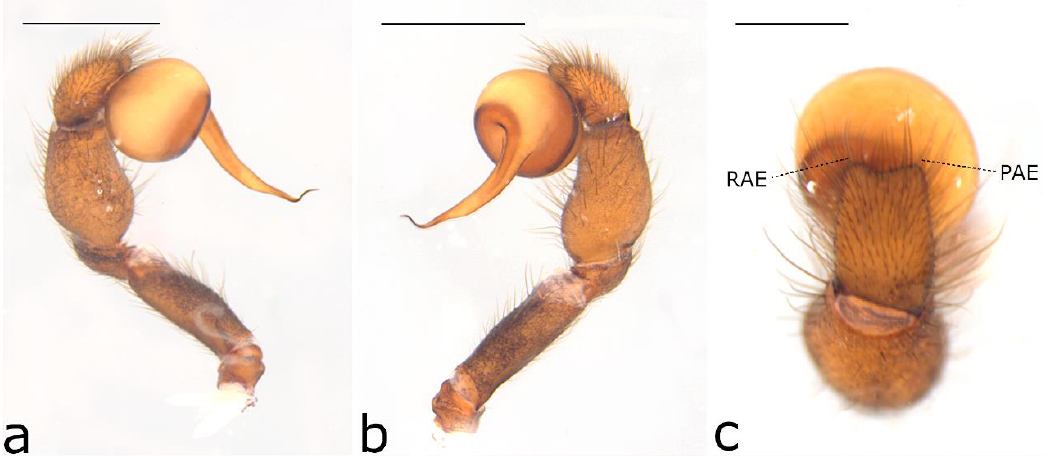
Figure 18. Ariadna formosa sp. nov. ♂ holotype (SAMA NN10565) from Indulkana (SA): ( a ) left pedipalp, prolateral view; ( b ) same, retrolateral view; ( c ) same, cymbium. Scale bar = 1 mm.